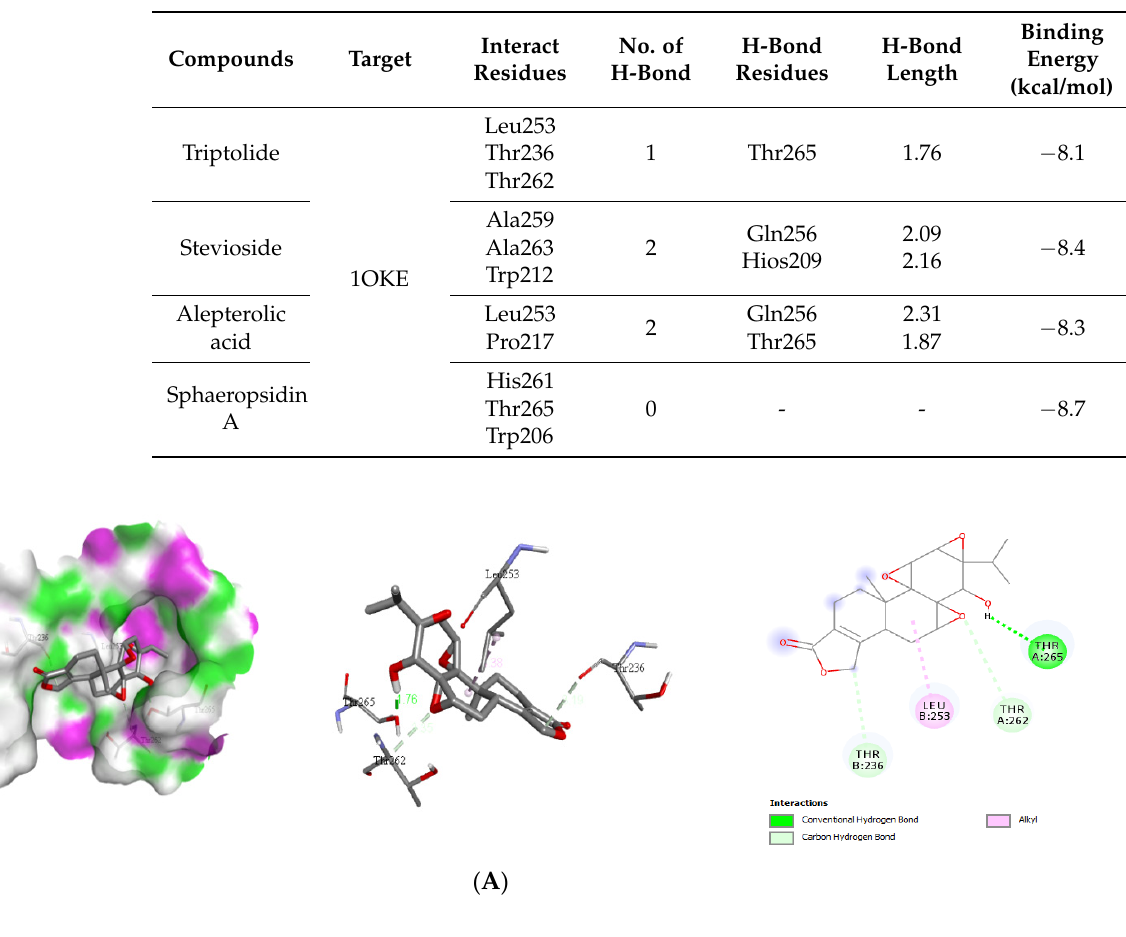
Table 2. The four best results for the docking of natural bioactive ligands with viral envelope (E) protein (PDB ID: 1OKE) proteins target.